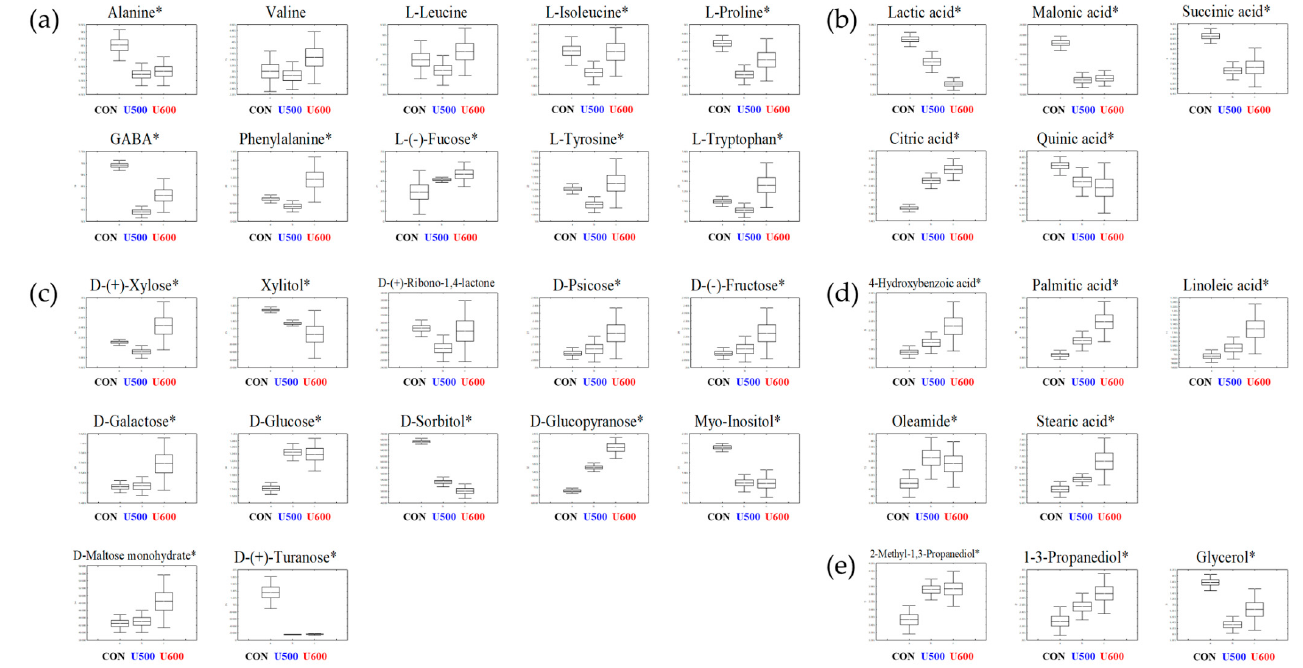
Figure 2. Box and whisker plots of significantly different metabolites among GBPs obtained after different UHP processing treatments. ( a ) Amino acids; ( b ) organic acids; ( c ) sugars and sugar alcohols; ( d ) fatty acids; and ( e ) others are shown. Relative contents of metabolites of GBP obtained after different processing treatments were calculated as a relative peak area in GC-TOF-MS analysis. The metabolite content corresponds to the relative peak area plotted in the Y -axis. ( Line , mean; box , Standard error; whisker , standard deviation) The GBP obtained after different UHP processing treatments plotted in the X -axis. (CON, control; U500, 500MPa; U600, 600MPa) * p -value < 0.05.